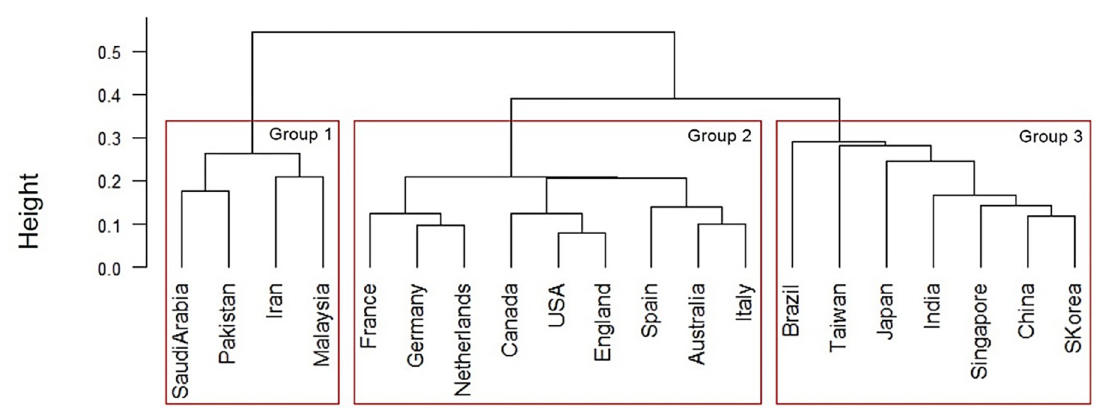
Fig 12. Similarity dendrogram by country: Links between author research areas in the top 20 big data countries. Note . Distance: hclust ( � , “ward.D2”).